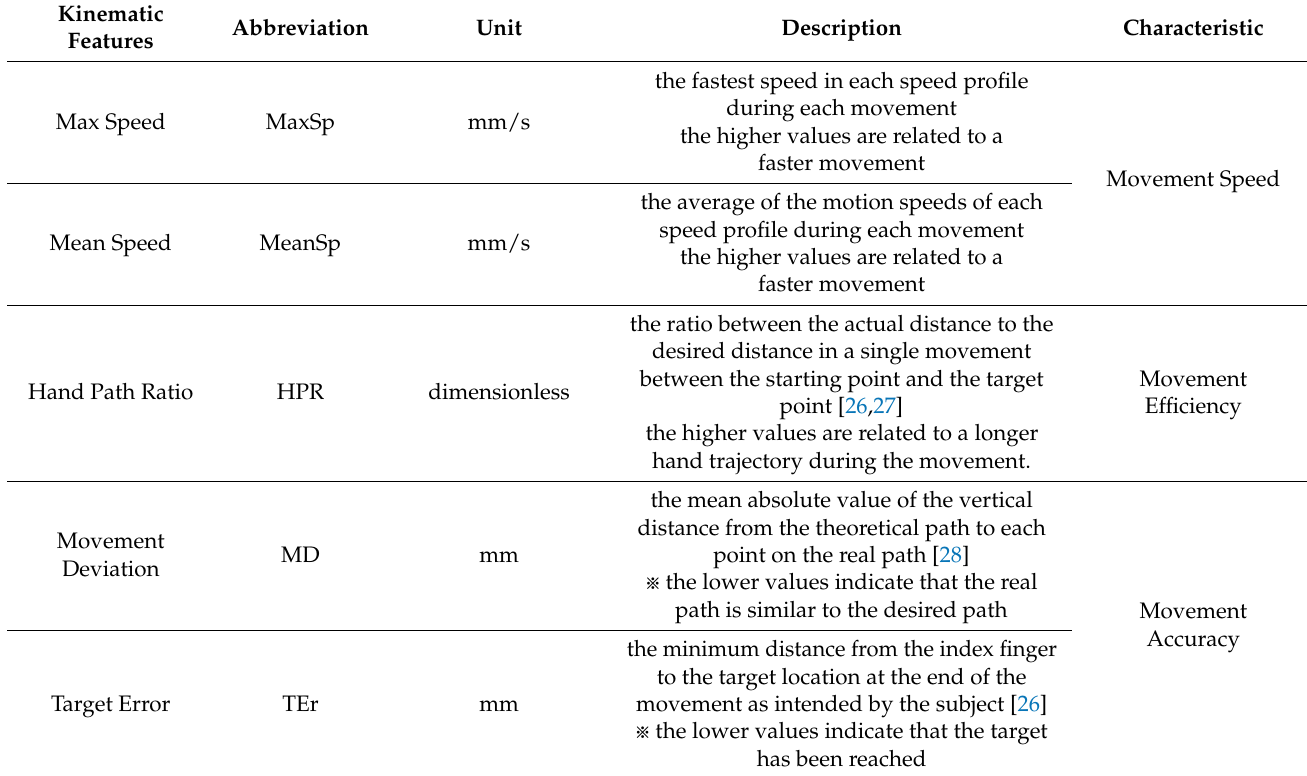
Table 1. Descriptions of kinematic features.